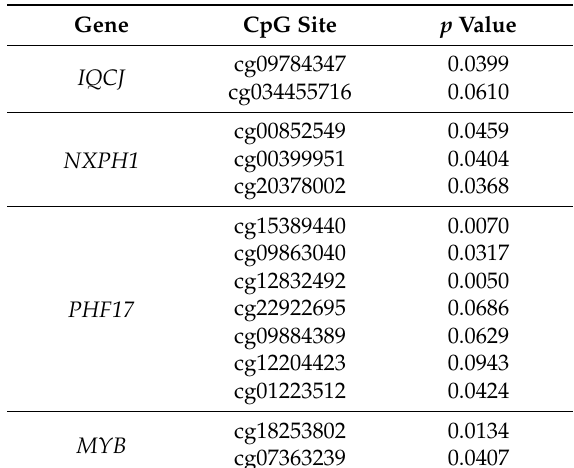
Table 6. Marginal and significant correlations between pre-supplementation triglyceride levels and DNA methylation levels ( n = 35